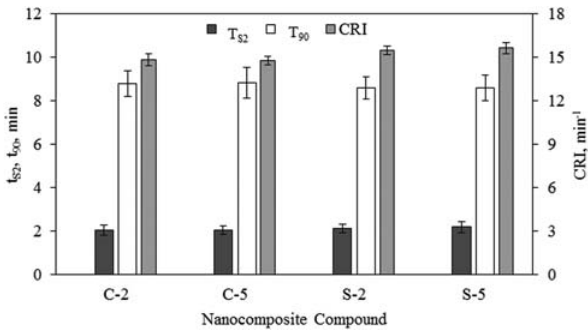
Figure 5: Cure properties of C and S nanocomposite